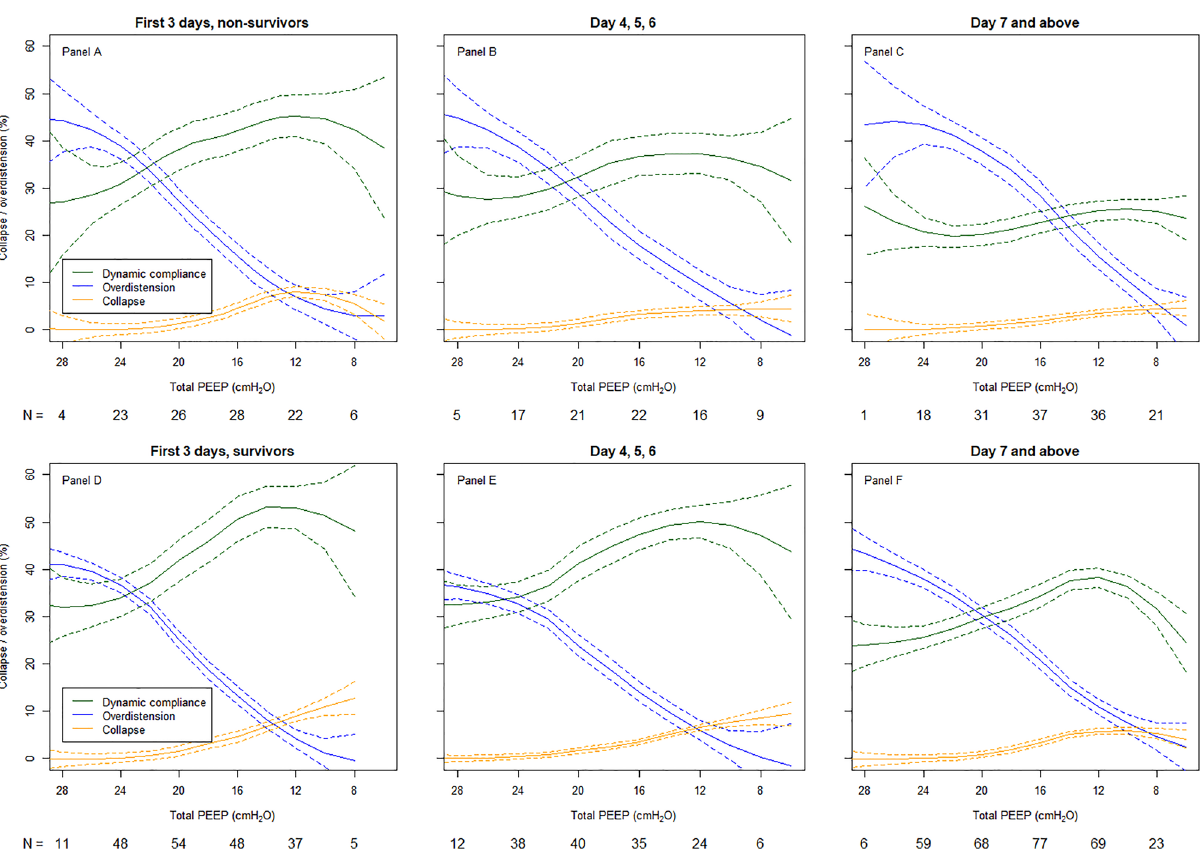
Figure 4. Dynamic respiratory system compliance, alveolar overdistension, and alveolar collapse for the whole population from admission to beyond a week after in ICU survivors and ICU non-survivors. EIT population curves that show mean (solid lines), dynamic compliance (green), overdistension (blue), and collapse (yellow) with 95% confidence intervals (dashed lines) from PEEP steps 28 to 8 cmH 2 O for ICU non-survivors over time for the first 3 days ( A ), for day 4, 5 and 6 ( B ) and for day 7 and above ( C ); and for ICU survivors over time for the first 3 days ( D ), for day 4, 5 and 6 ( E ) and for day 7 and above ( F